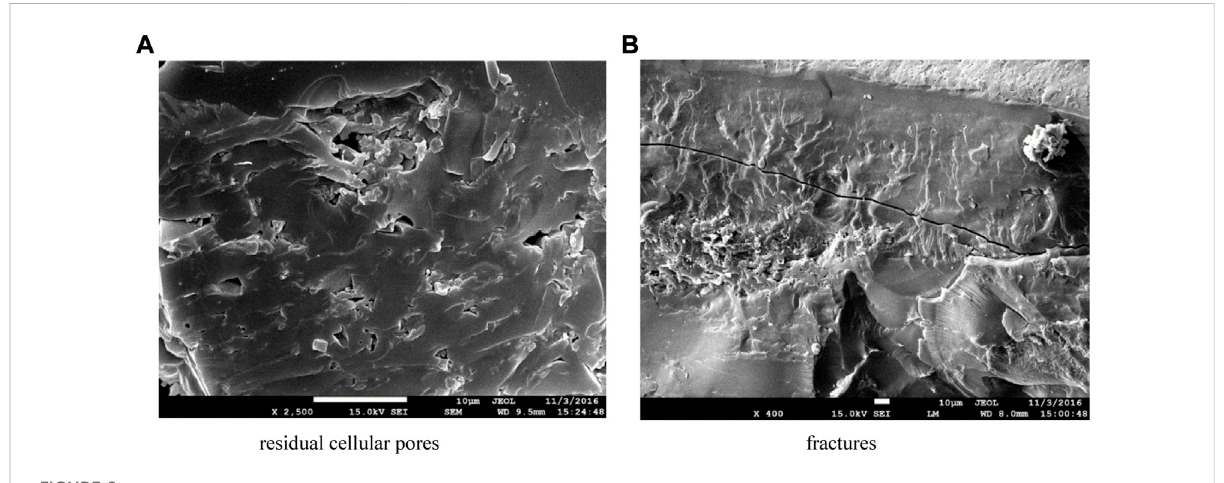
FIGURE 2 Microscopic characteristics of pores and